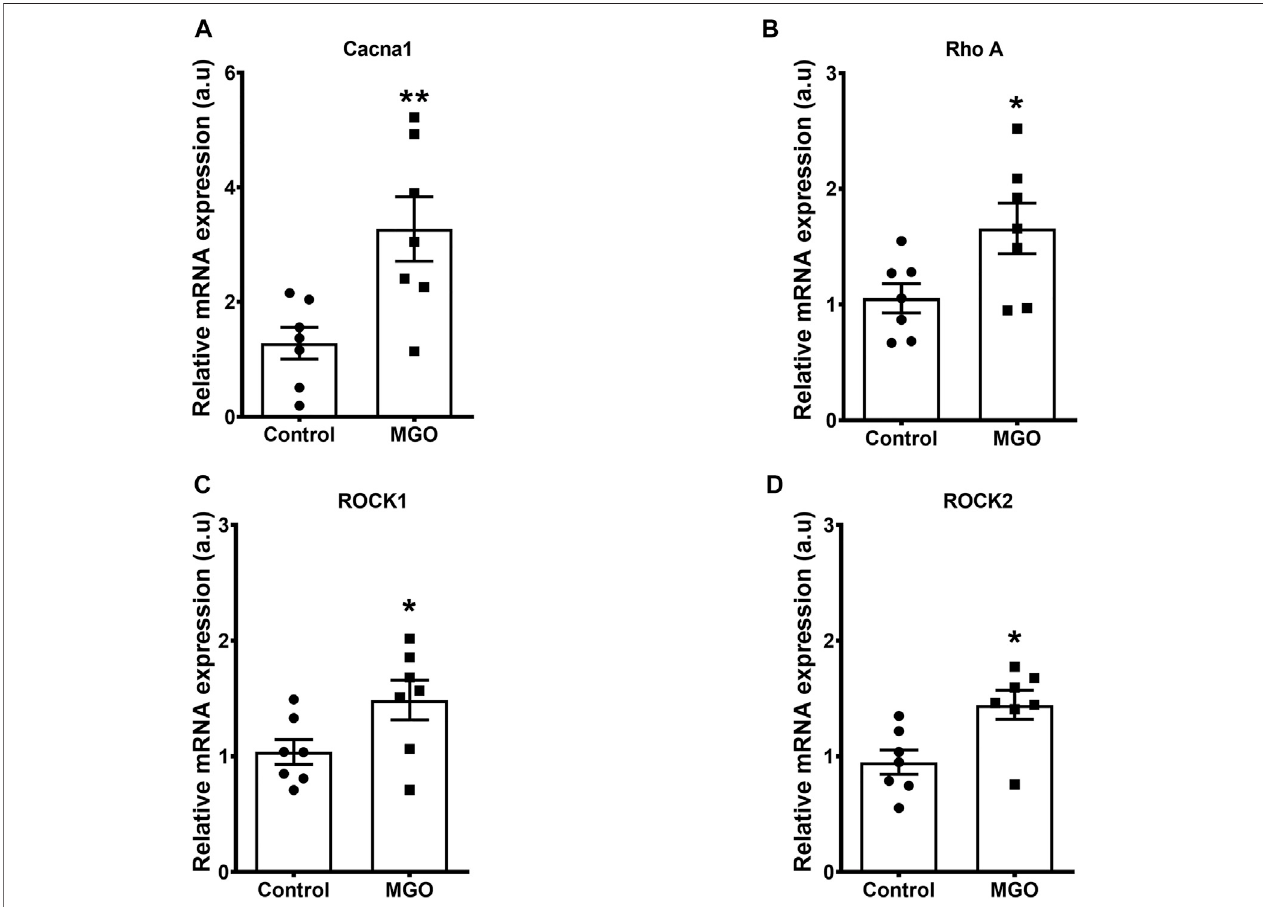
FIGURE5| Methylglyoxal (MGO)treatmentincreasesthemRNAexpressionsofL-type Ca 2+ channels (A) ,RhoA (B) ,ROCK1 (C) and ROCK2 (D) inintactbladder tissues. Data are expressed as mean ± SEM for n = 7. * p < 0.05 compared with control group.